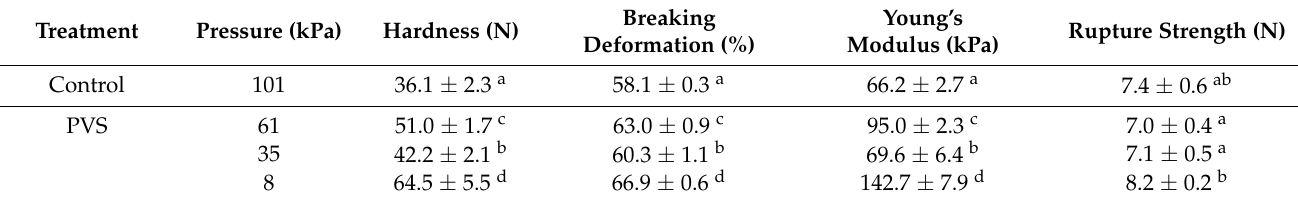
Table 3. Effect of working pressures on the textural characteristics of calcium-alginate hydrogel balls obtained at the pressurization time of 3 cycles 1